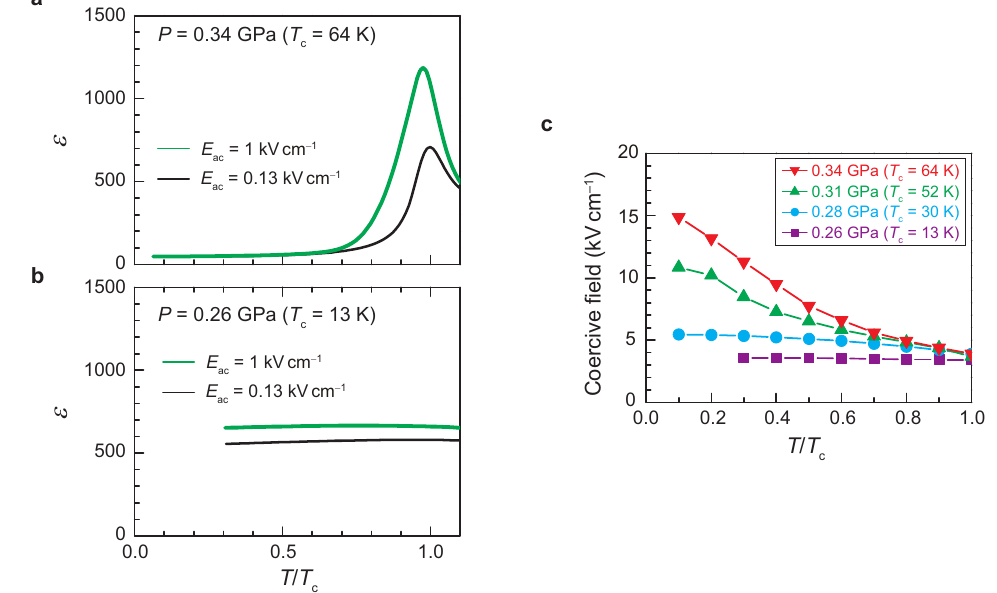
Figure 4. ( a , b ) Permittivity–temperature profiles measured under a.c. electric fields of different magnitudes: at 0.34 GPa ( T c ≈ 64 K) ( a ) and at 0.26 GPa ( T c ≈ 13 K) ( b ), the latter of which is close to the ferroelectric QCP. ( c ) Temperature dependences of the coercive electric field at different pressures. In ( a – c ), the temperatures are represented in the form of reduced temperatures, T / T c